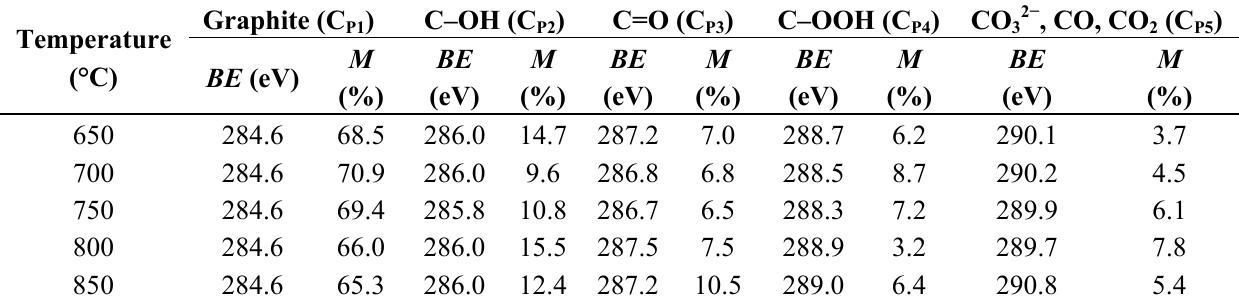
Table 3. XPS results of the peak fits of the C1s and O1s